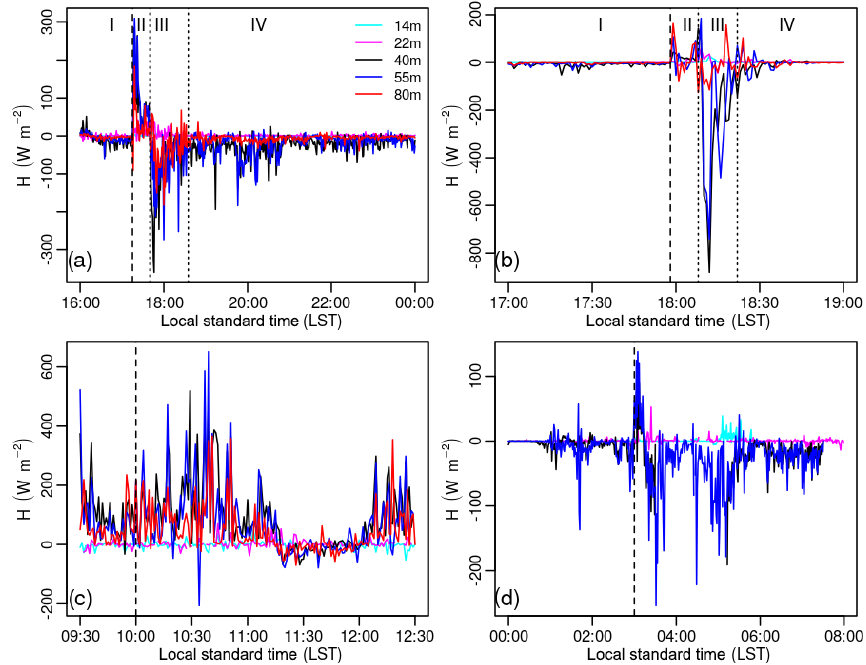
Figure 4. The same as in Fig. 2 but for sensible heat